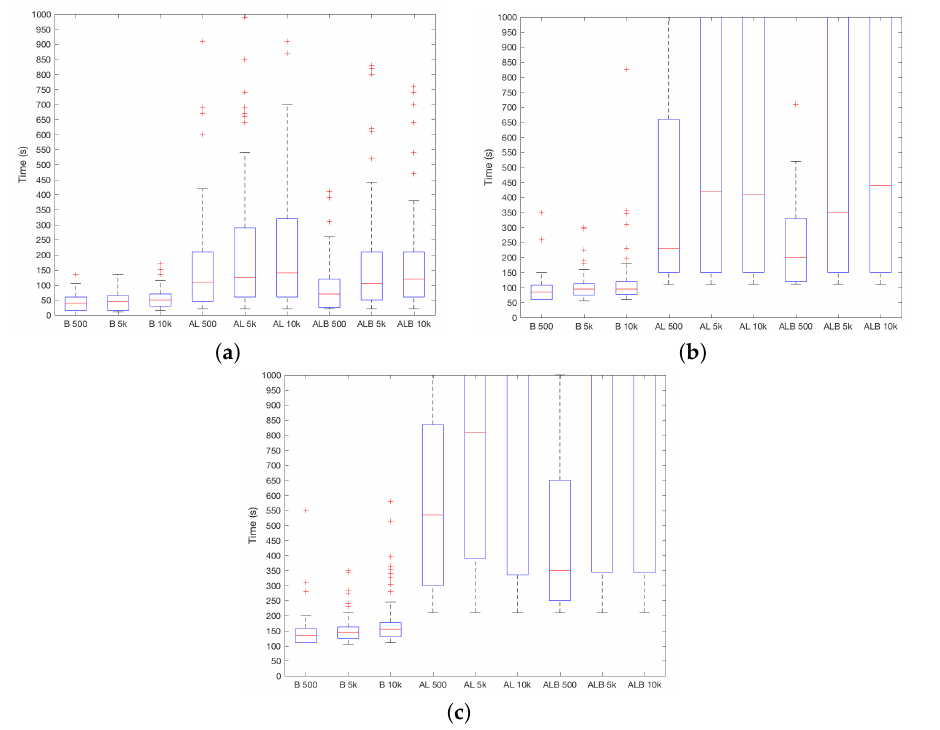
Figure 7. T SEC results depending on the length of the learning period. ( a ) ST = 1; ( b ) ST = 10; ( c ) ST =